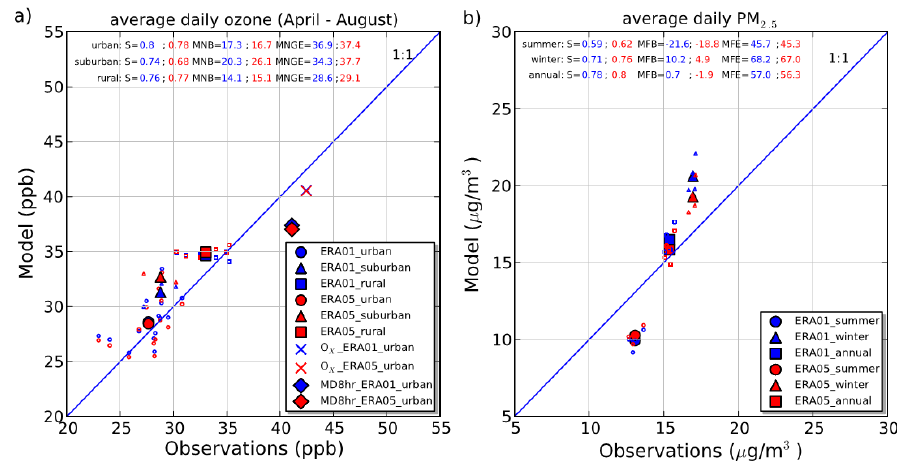
Figure 5. Scatter plots and scores for the sensitivity test on the resolution of meteorology for ozone and PM 2 . 5 .